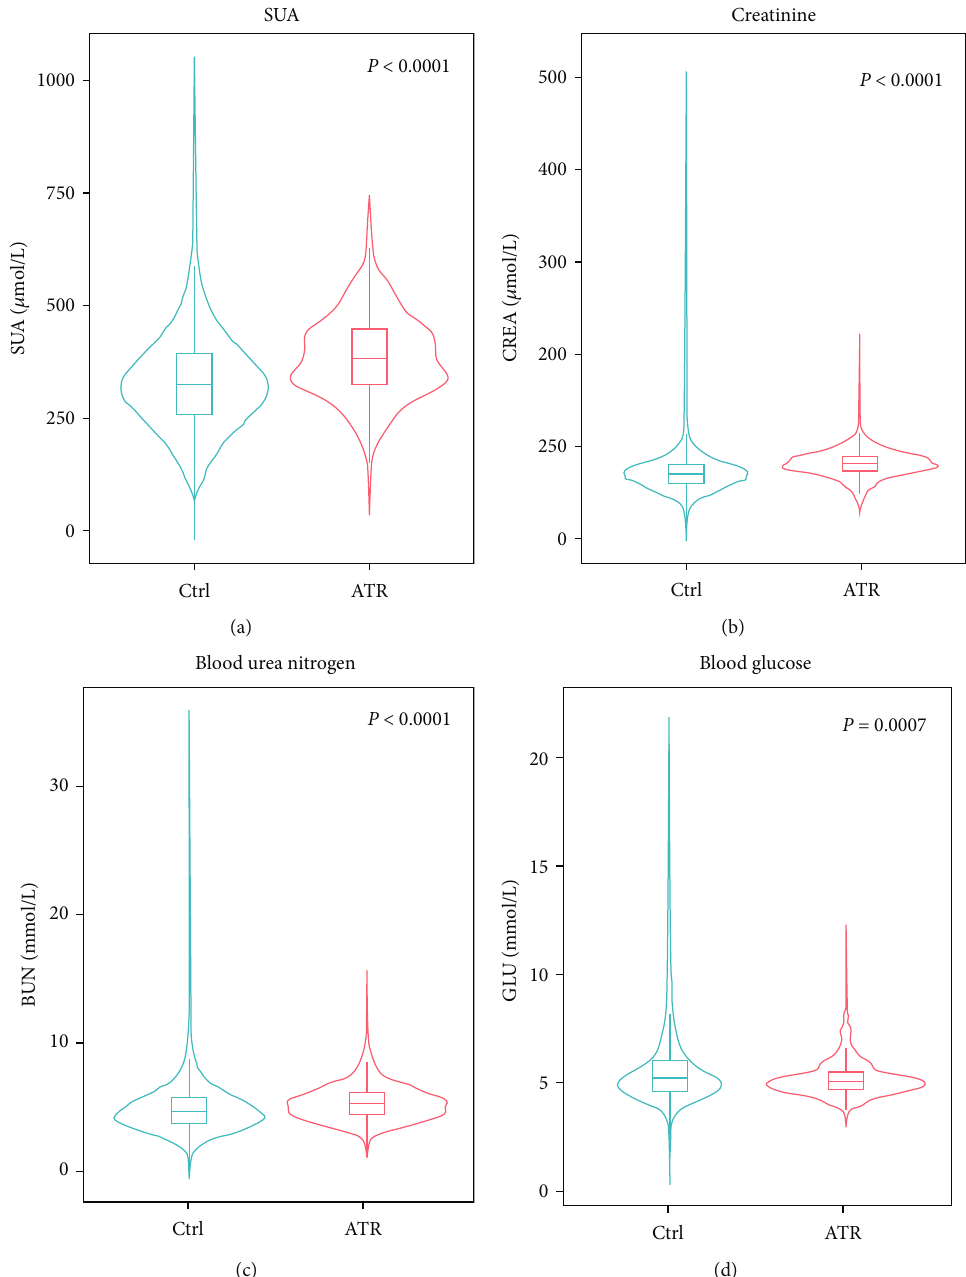
Figure 1: Comparison analyses between the ATR group and the control subjects. The levels of SUA ( P < 0 : 0001 ) (a), creatinine ( P < 0 : 0001 ) (b), blood urea nitrogen ( P < 0 : 0001 ) (c), and blood glucose ( P = 0 : 0007 ) (d) exhibited signi fi cant di ff erences in ATR patients ( n = 648 ) and the control group of volunteers ( n = 12559